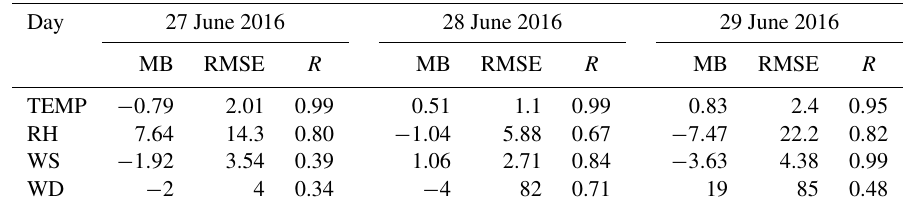
Table 3. Simulation scores for meteorological vertical profiles for 3d at DMC station in Santiago. WD is the wind direction at 10m. All other abbreviations are the same as for Table 2.